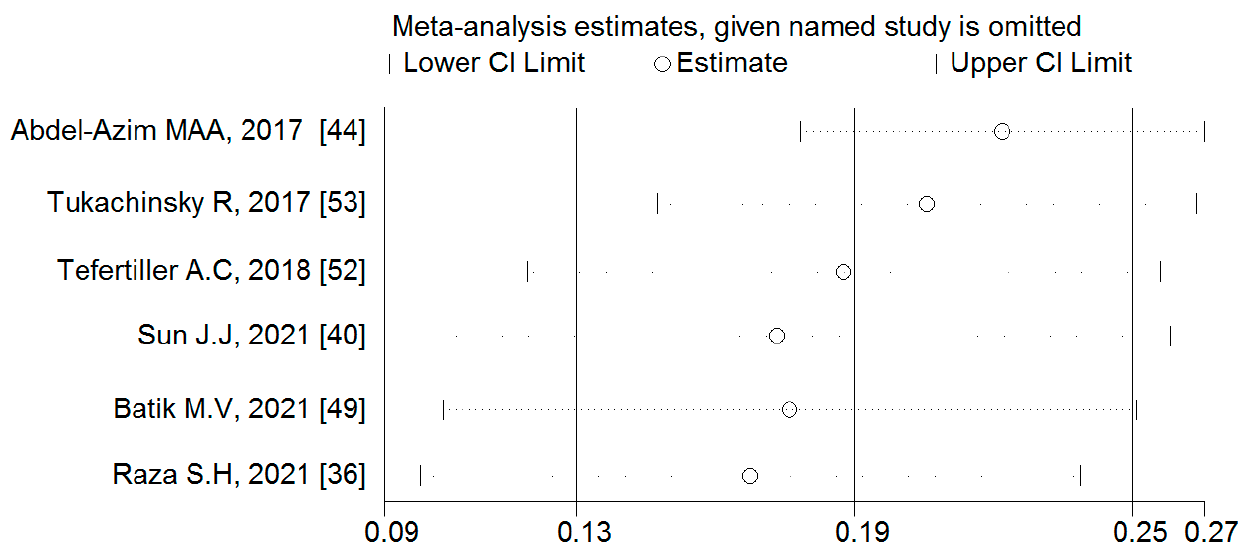
Figure 14. The sensitivity analysis plot assessing the small study effect in the estimated pooled Fisher’s z-score in the association between binge-watching and loneliness.